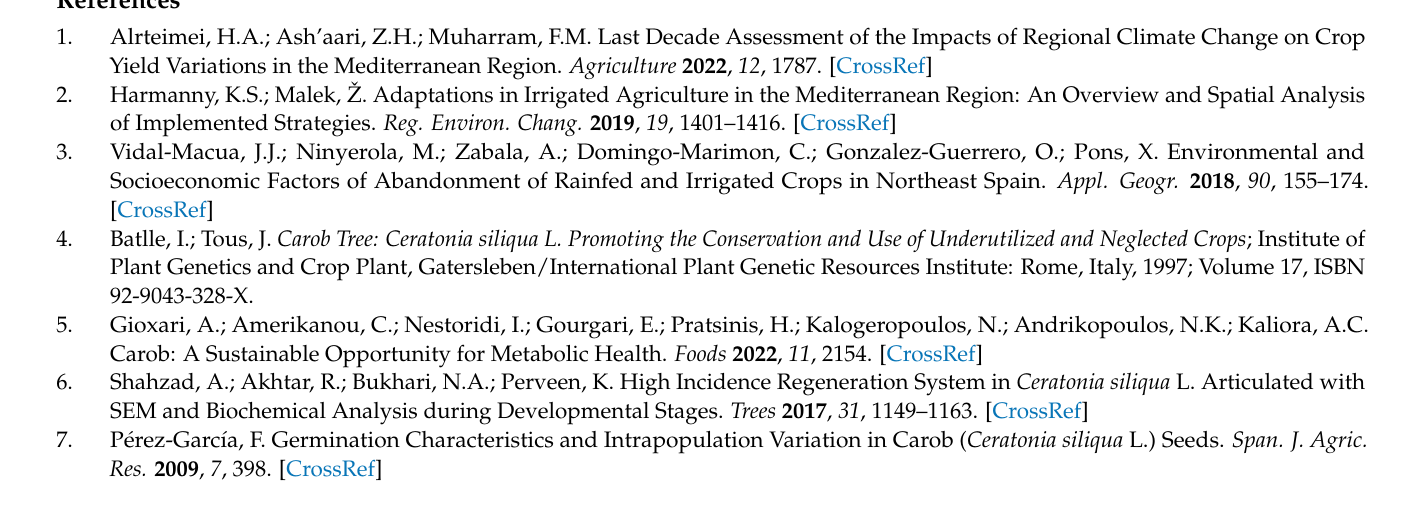
Figure S3: Pearson correlation coefficients and hierarchical clustering using the Euclidean distance between the different biochemical parameters measured in this